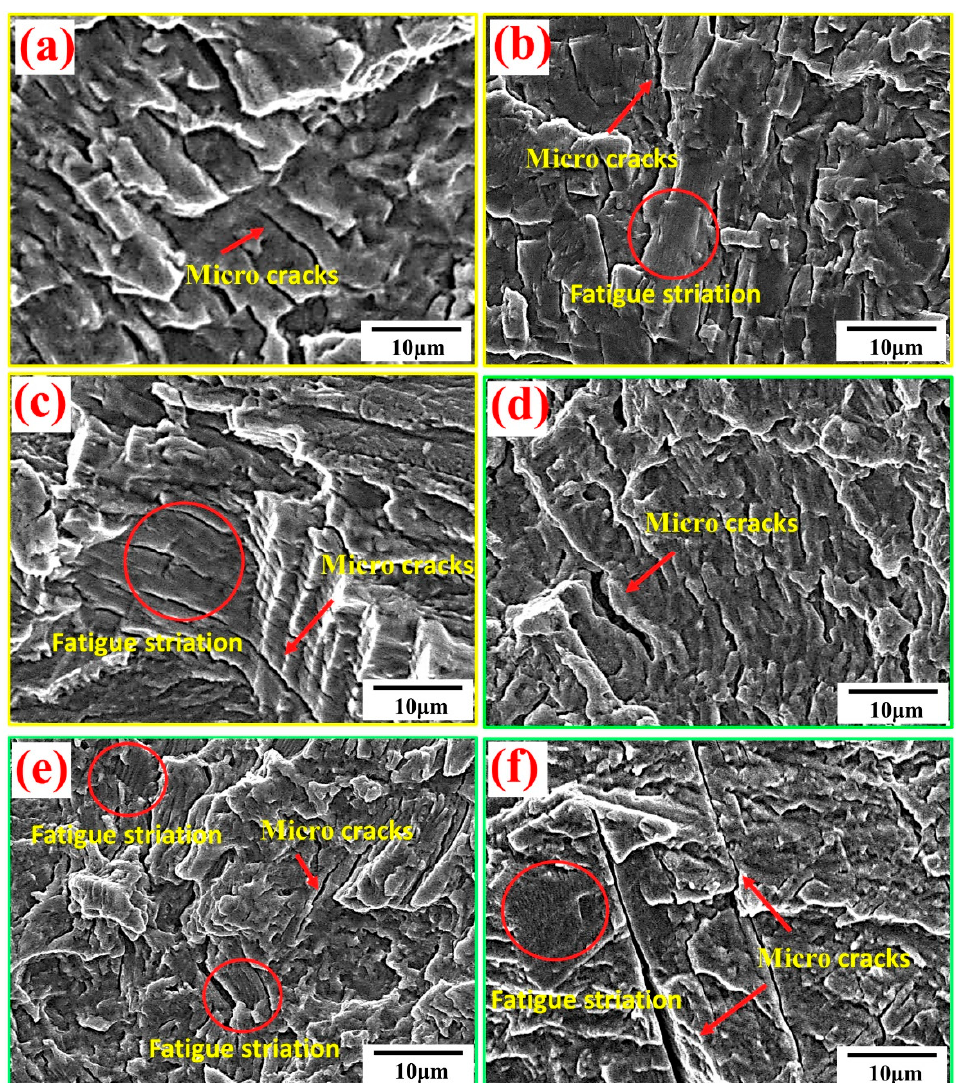
Figure 12. Fracture surfaces of different specimens on Paris zone: ( a ) 850FC, ( b ) 950FC, ( c ) 1050FC, ( d ) 850WAC, ( e ) 950WAC, ( f ) 1050WAC.